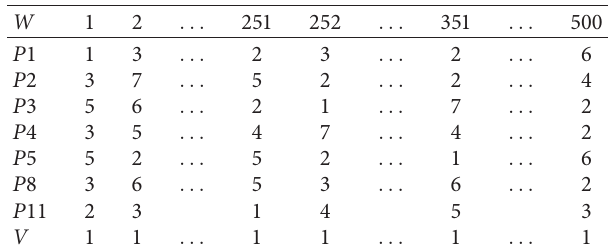
Table 1: Decision table